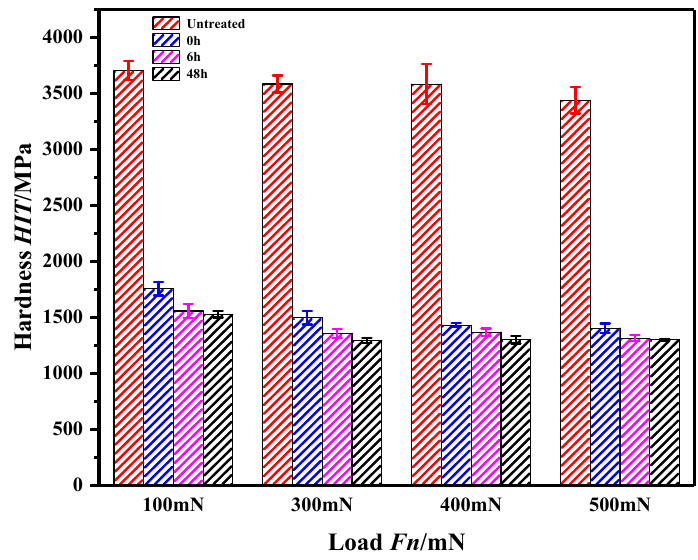
Figure 8. Curves of surface microhardness of pure iron under different loads and treatments.